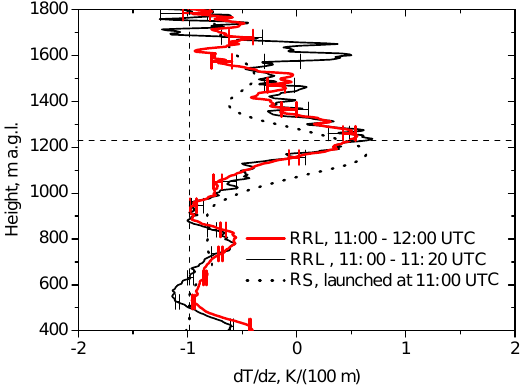
Figure 4. Average temperature gradients measured with the UHOH RRL on 24 April 2013 between 11:00 and 11:20UTC, between 11:00 and 12:00UTC and temperature gradient measured with a lo- cal radiosondes launched at the lidar site at 11:00UTC. The hori- zontal dashed line shows z i , the mean CBL top height for the period between 11:00 and 12:00UTC, which agrees with the maximum temperature gradients of both RRL profiles. The vertical dashed line shows the dry-adiabatic temperature gradient. Error bars show the uncertainties derived with Poisson statistics from the intensities of the rotational Raman